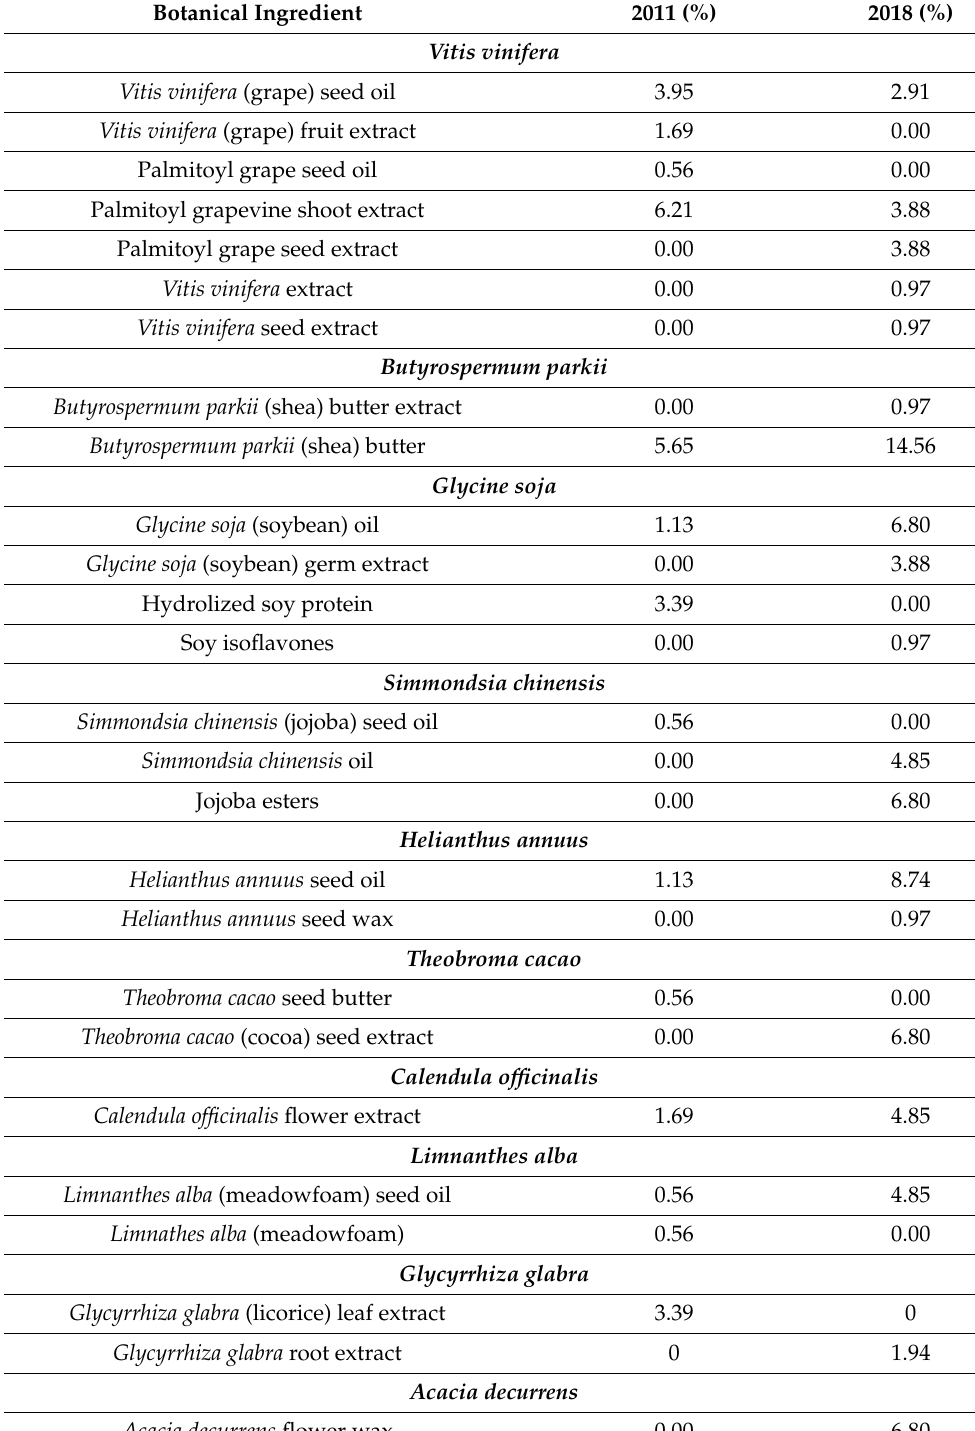
Table 2. Botanical ingredients found in INCI lists from analyzed anti-aging products and their relative